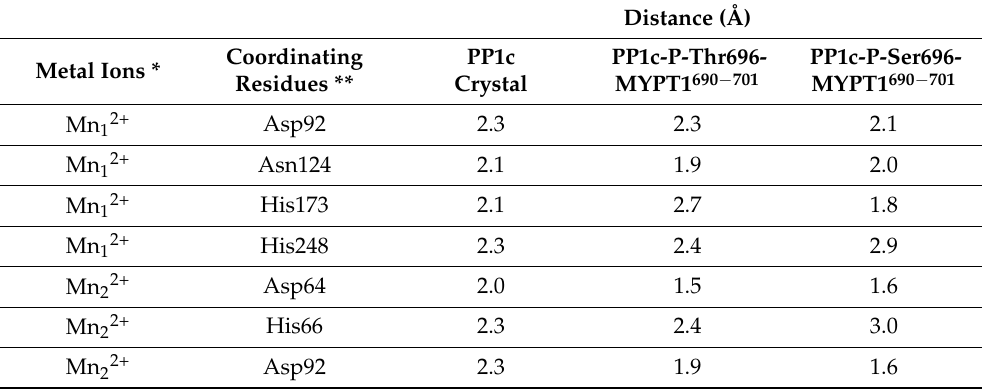
Table 1. Distances between the metal ions and their coordinating amino acid residues in docked PP1c–peptide complexes and in crystal